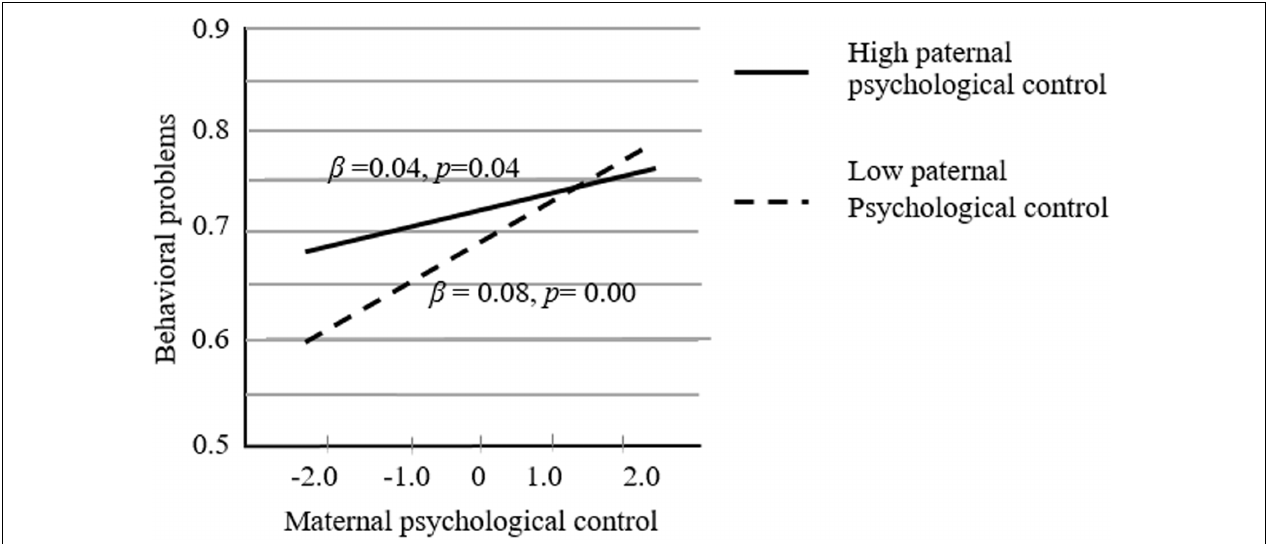
FIGURE 2 | The joint effect of paternal and maternal psychological control (maternal psychological control as the independent variable and maternal psychological control as the